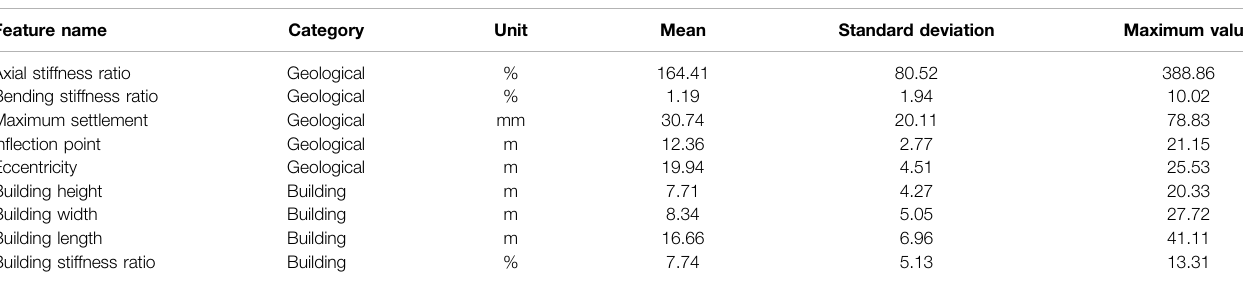
TABLE 1 | Description of geological and building